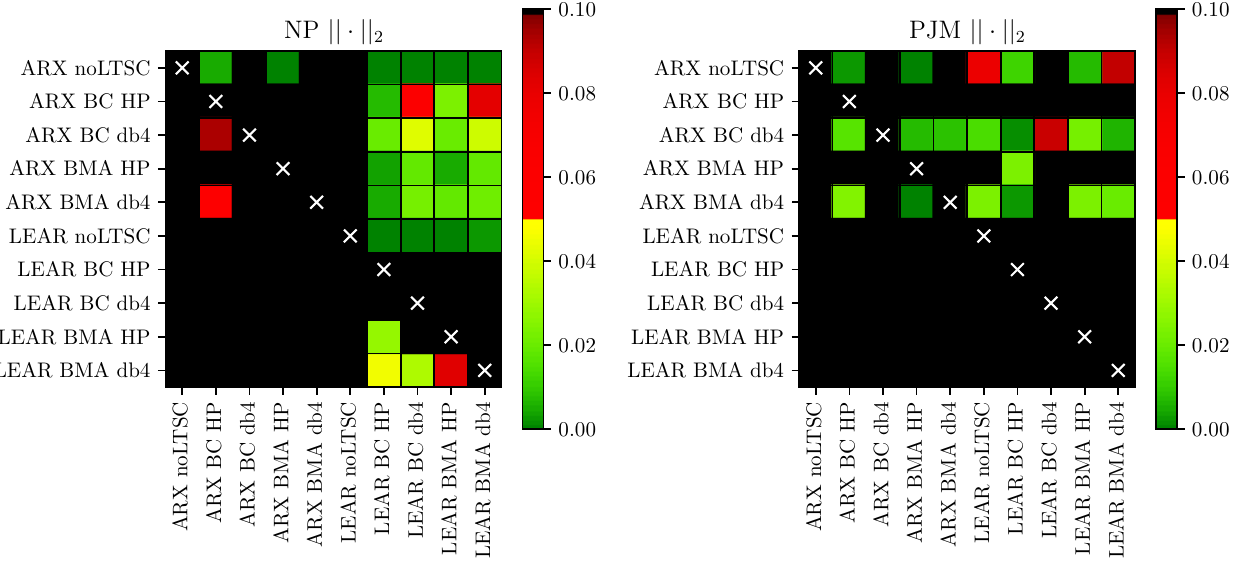
Figure 7. Results of the CPA test [32] for absolute losses. A colored square (other than black) indicates that the predictions of the model on the x-axis are significantly better than the predictions of the model on the y-axis, at a given significance level.